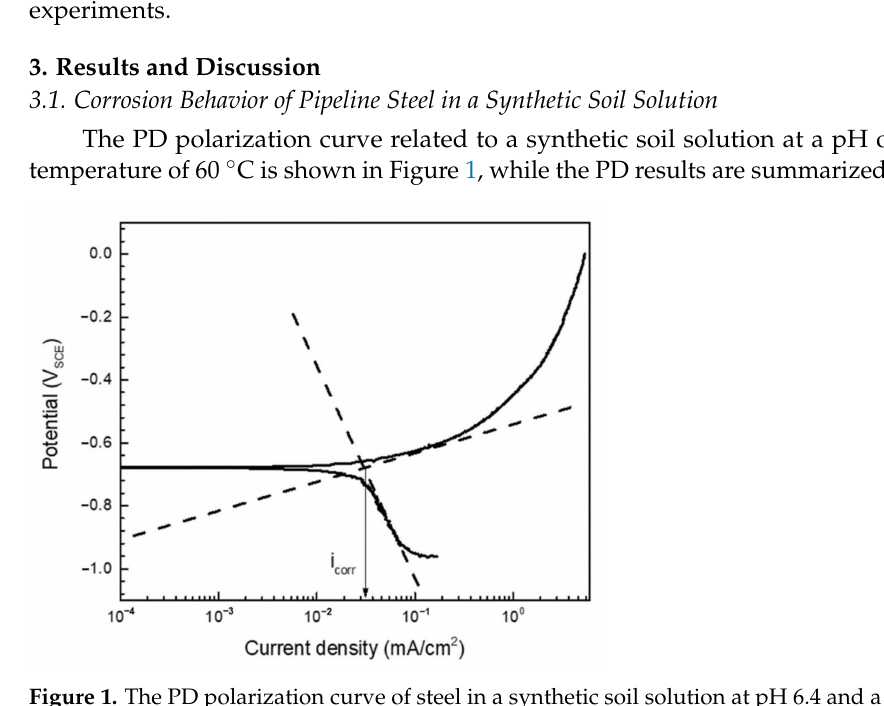
Figure 1. The PD polarization curve of steel in a synthetic soil solution at pH 6.4 and a temperature of 60 ◦ C. Table 3. Results of the PD (potentiodynamic) polarization